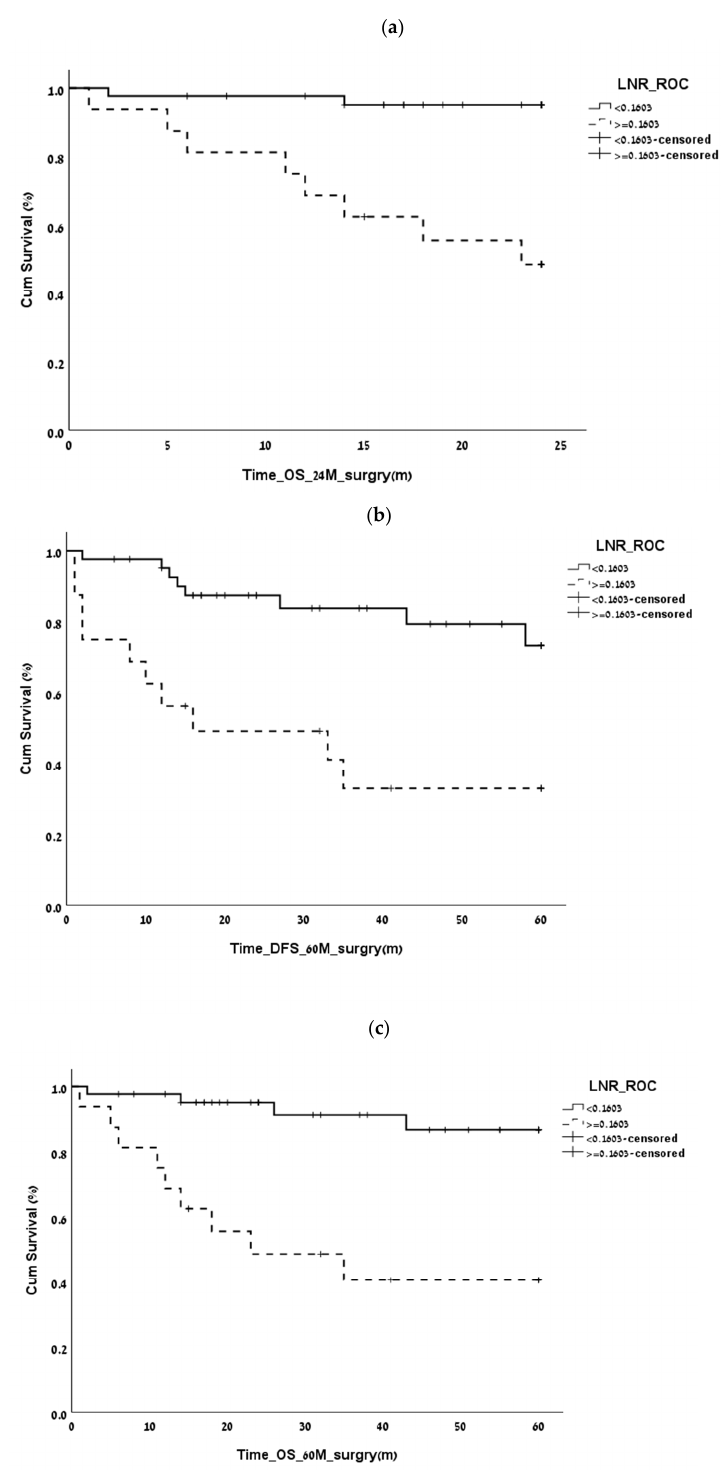
Figure 3. Correlation of lymph node ratio (LNR) with the outcome at 2 and 5 years postoperatively. ( a ). LNR: 2-year overall survival (OS) ( p = 0.0016). ( b ). LNR: 5-year disease-free survival (DFS) ( p = 0.001). ( c ). LNR:5-year overall survival ( p = 0.004).